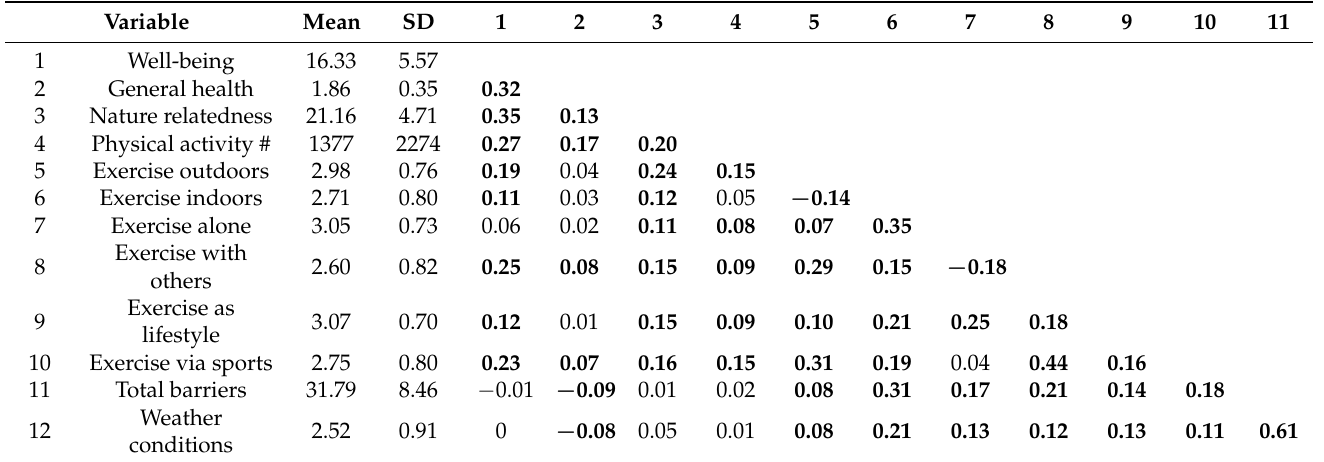
Table 4. Correlations between well-being, nature relatedness and physical activity variables.